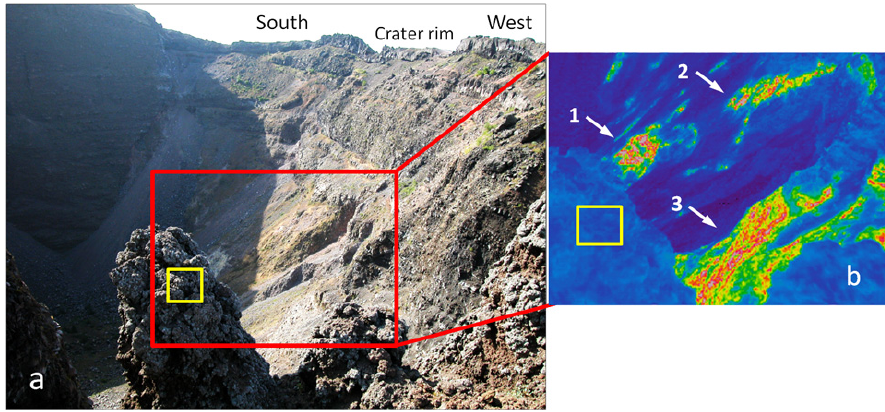
Figure 5. View from Northwestern rim of Vesuvius crater (a) and IR acquired image(b). The arrows point toward the areas affected by the ther- mal anomaly characterized by the most radiant pixels of the IR scene. The yellow box represents the background area used for the analysis.